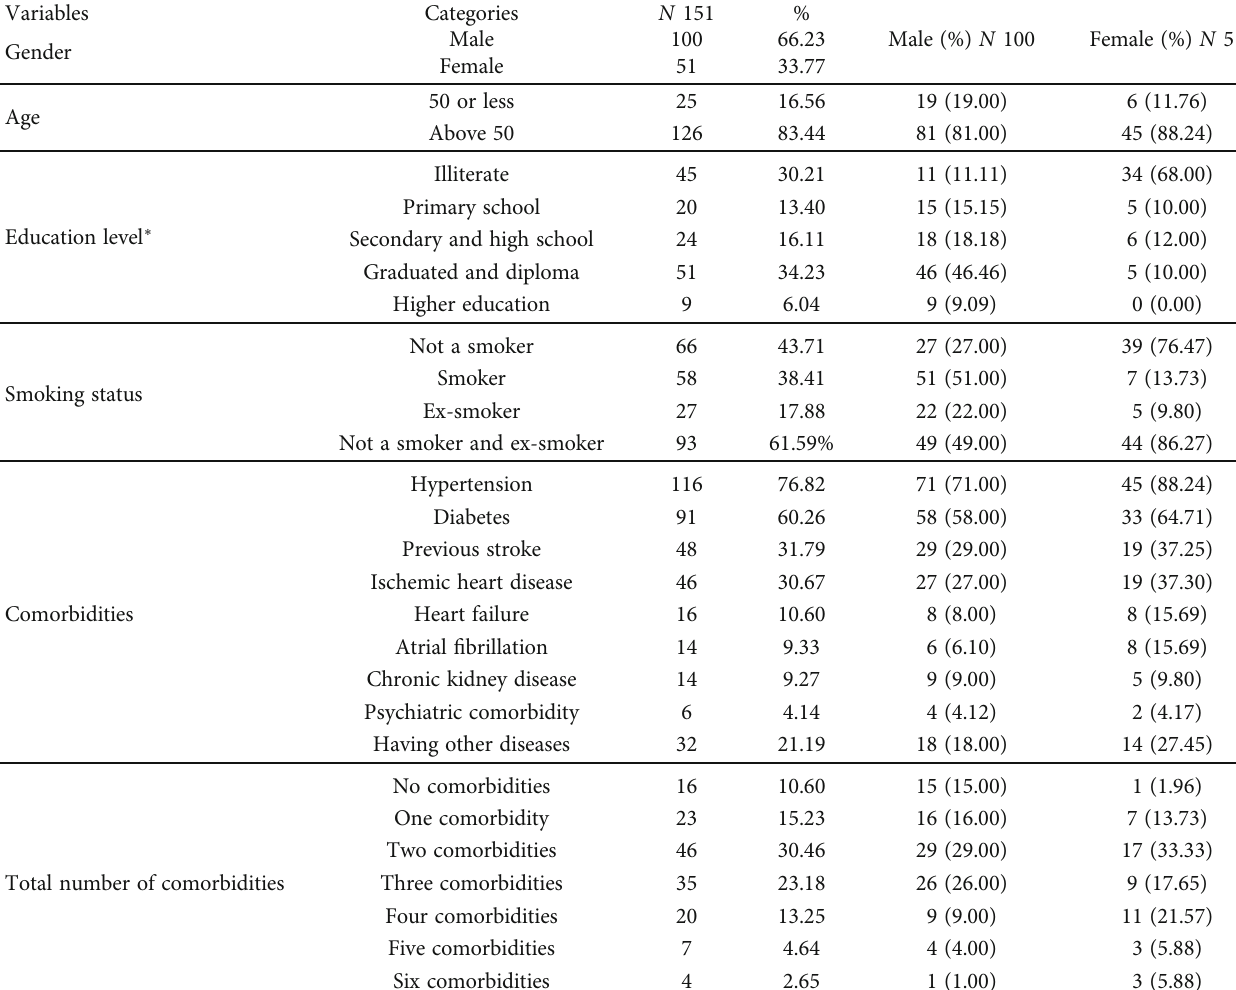
Table 1: Cohort demographics and risk factor pro fi